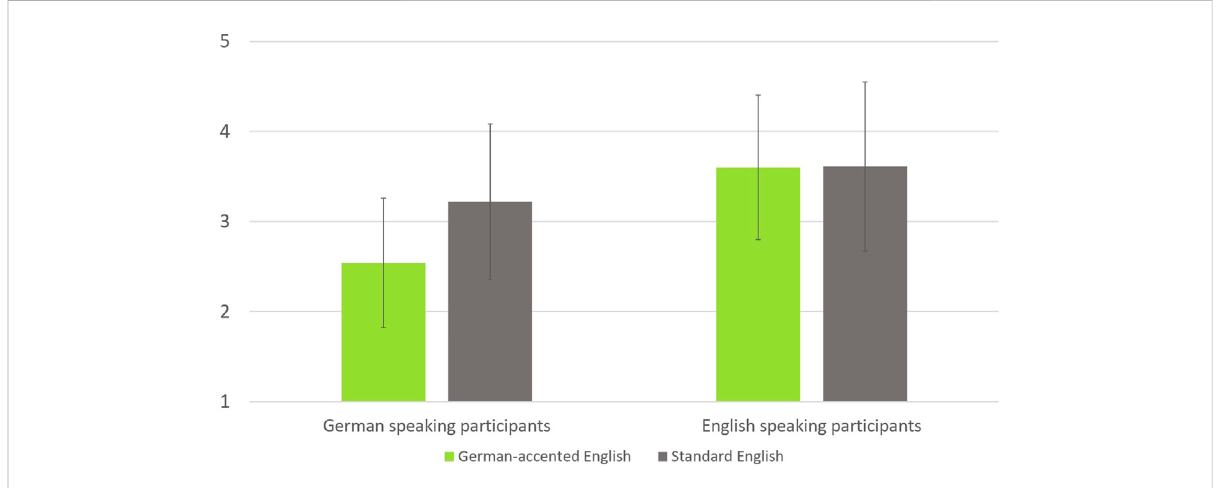
FIGURE 2 The results for perceived competence of the virtual robot in the different conditions. Error bars show the standard